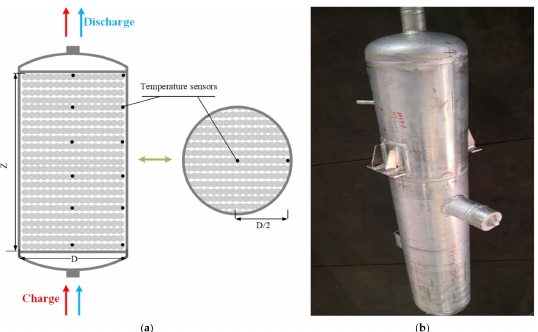
Figure 3. Chart of the charge and discharge process of packed bed energy storage ( a ) and the picture of cold storage packed bed ( b